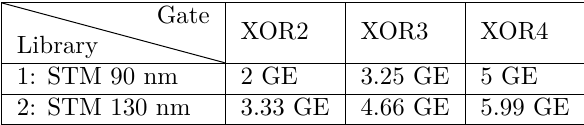
Table 1: Logic libraries with gates and the corresponding costs.